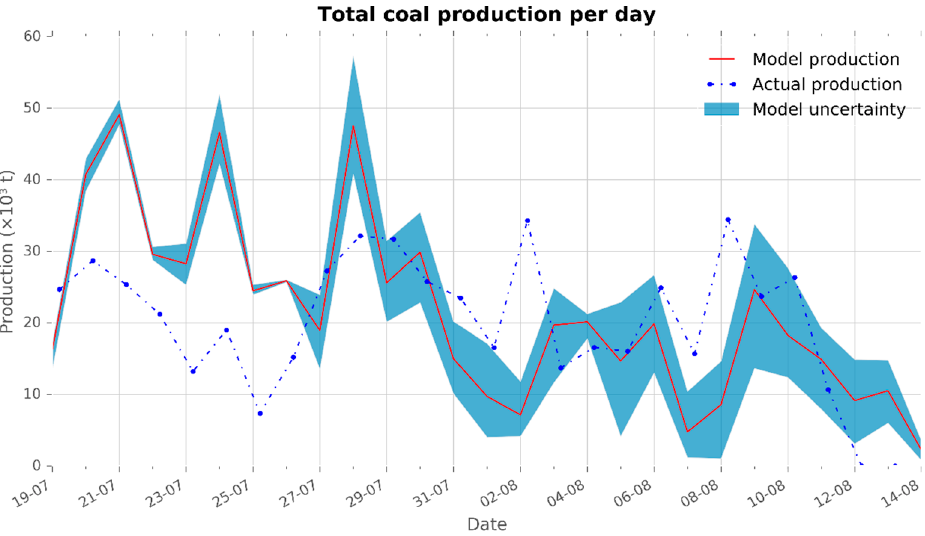
Figure 17. Comparison of daily production of coal, Experiment 3.